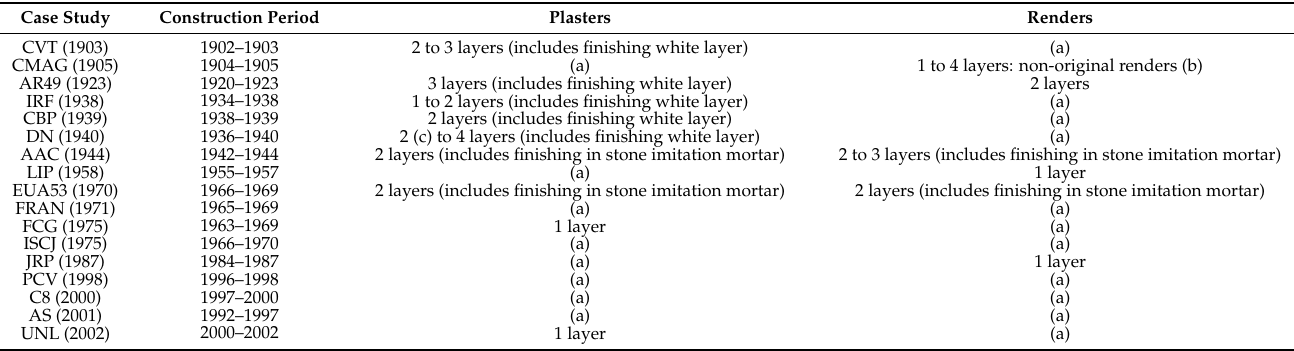
Table 5. Stratigraphy of plasters and